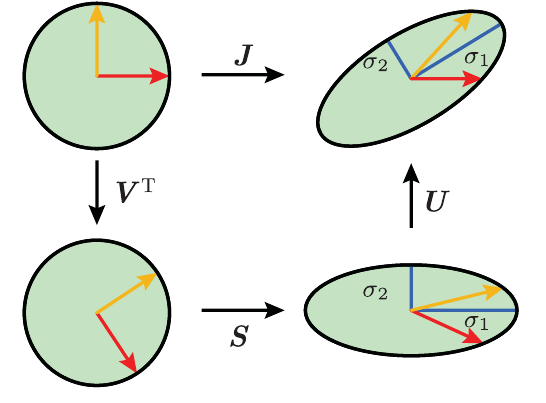
Fig. 6 Illustration for the